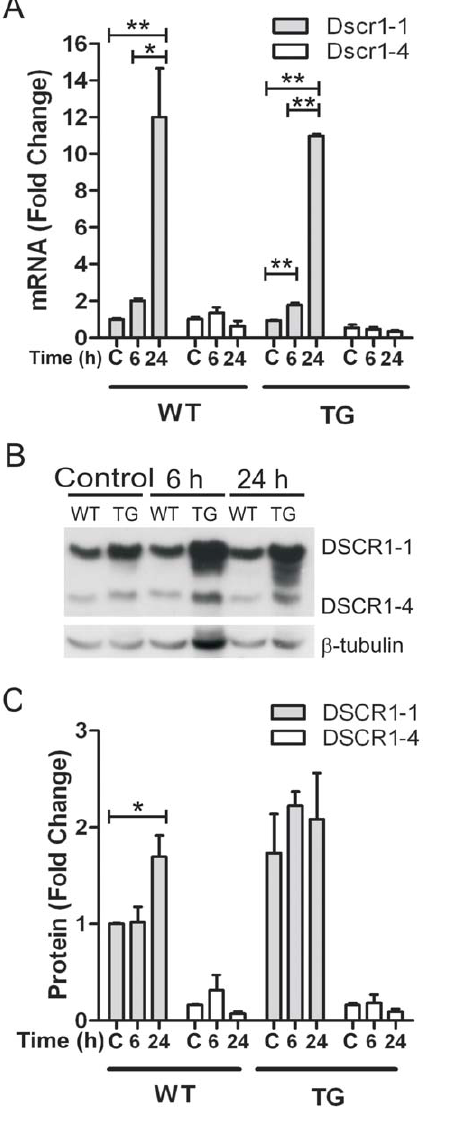
Figure 2. DSCR1 expression in the brain of WT and DSCR1-TG mice following stroke. qRT-PCR and Western blot analyses were used to assess the expression of DSCR1 isoform 1 (grey bars) and 4 (white bars) in WT and DSCR1-TG mice. Expression was assessed in naı¨ve control mice [C] and in mice at 6 and 24 h after ischemia. (A) Endogenous Dscr1-1 mRNA was increased at 6 and 24 h following stroke, although there was no difference between WT and DSCR1-TG. DSCR1-4 gene expression was not altered by ischemia in either group. (B and C) A representative Western blot is shown using an antibody that recognises both isoforms of DSCR1 protein, and cross-reacts with both mouse (endogenous) and human (transgene) proteins. DSCR1-1 protein levels were higher in DSCR1-TG compared with WT due to over- expression of the human DSCR1-1 transgene. DSCR1-1 protein was increased by , 2-fold after ischemia in WT, but did not change after ischemia in DSCR1-TG. There was no effect of ischemia on DSCR1-4 protein expression in either genotype. The data are presented as mean 6 SEM (n=3 per group). (*P , 0.05, **P , 0.01).